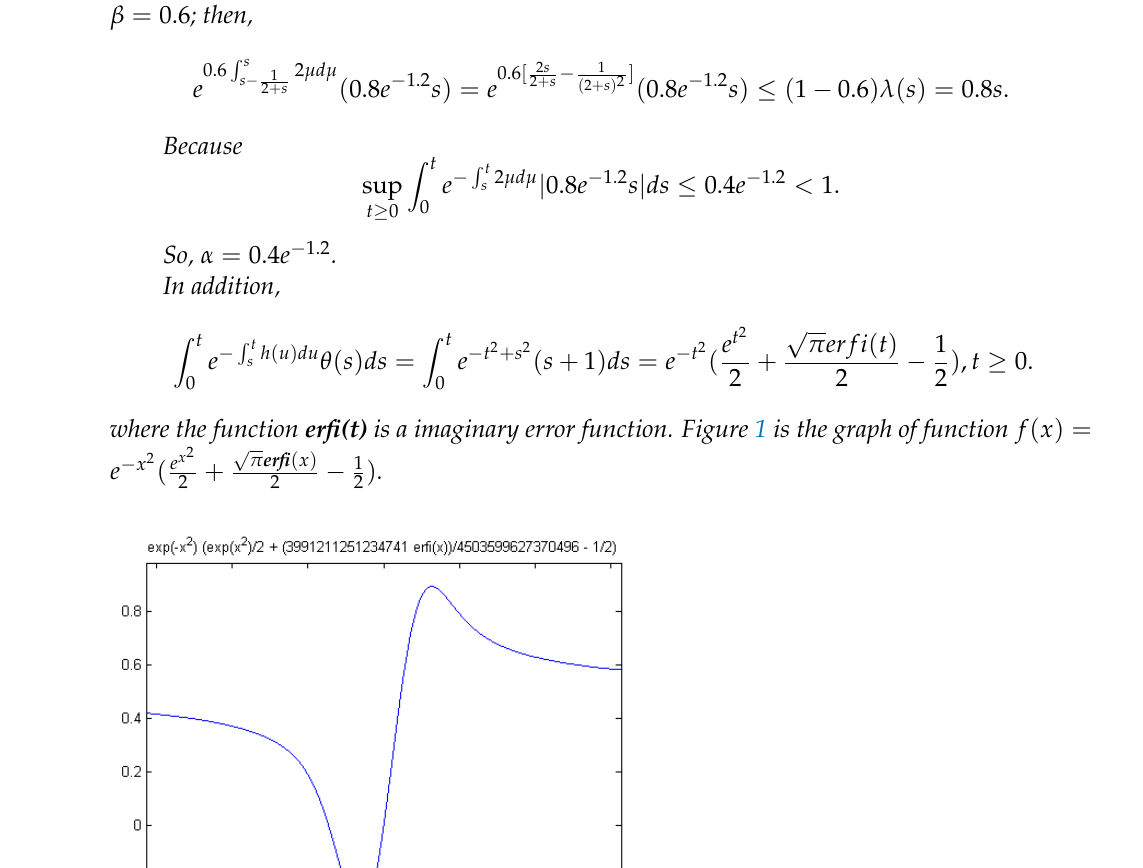
√ 2 π erfi ( x ) + − 1 ) 2 2 2